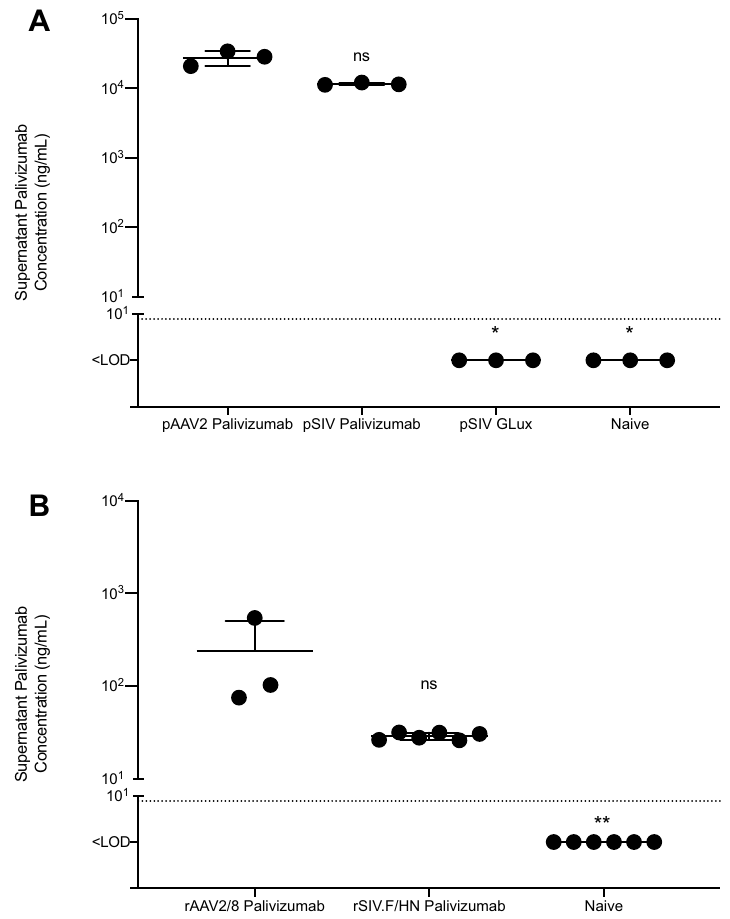
Figure 1. In vitro production of palivizumab from rAAV2/8 and rSIV.F/HN. HEK293T cells were ( A ) transfected with rAAV and rSIV vector genomes expressing palivizumab or GLux, were ( B ) transduced with rAAV and rSIV vector particles expressing palivizumab or remained naïve to treatment; 48 h post-transfection/ transduction, palivizumab levels in tissue culture supernatant was measured using a Human IgG ELISA. In several cases the errors are obscured by the mean bar, where appropriate, only positive error bars are shown. The dotted line represents the limit of detection (LOD). Differences between treatment and naïve control groups were evaluated using the Kruskal–Wallis test with Dunn’s post hoc multiple comparison